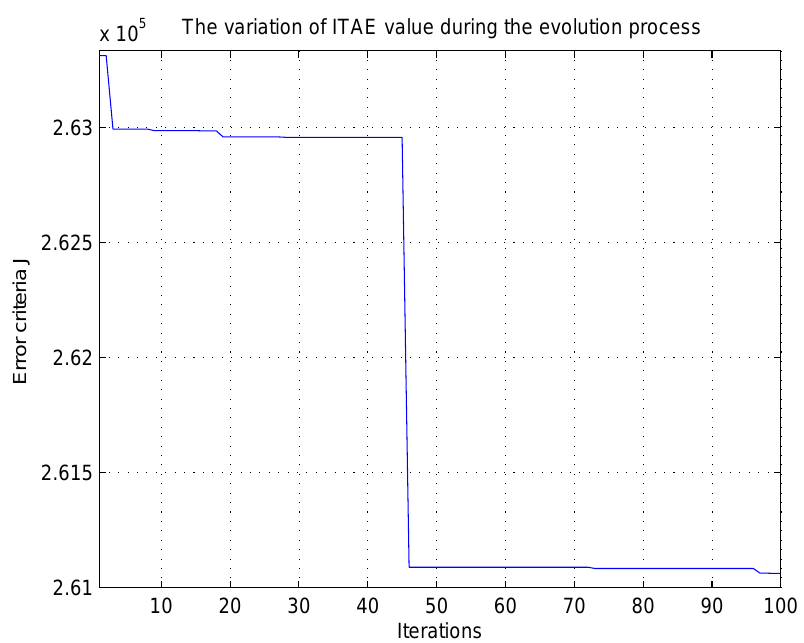
Variation of the objective function value during the evolution process for GA